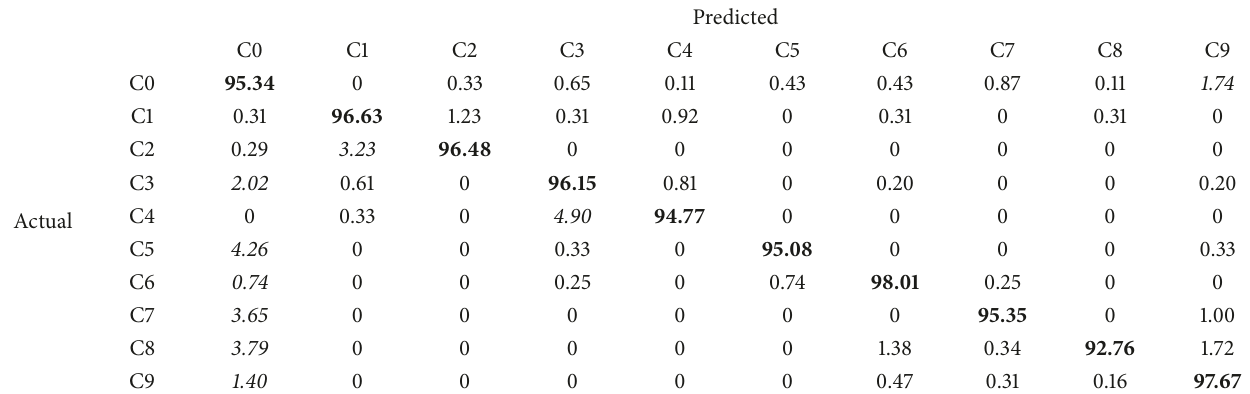
Figure 6: Non-frontal faces detection is challenging. A correctly detected face and a wrongly detected one by [14]. Air-conditioning openings are wrongly detected as a face. Table 2: Confusion matrix of our genetically weighted ensemble of classifiers on randomly selected test data.